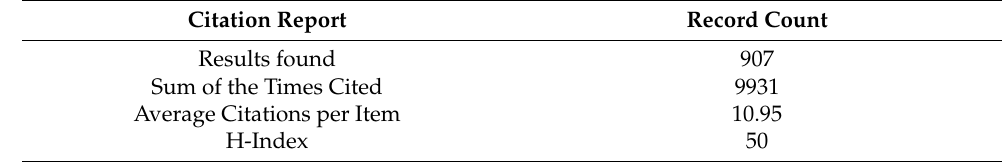
Table 2. Citation Report and Record